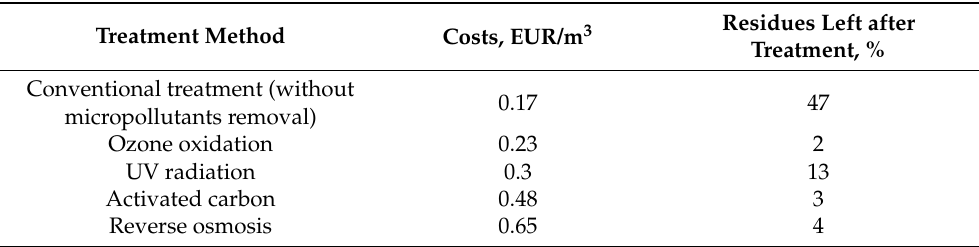
Figure 5. Bioanalytical testing of drinking water (adapted from [105]) . Table 5. The price of treatments to eliminate pharmaceutical pollutants from wastewater (data from [107]).